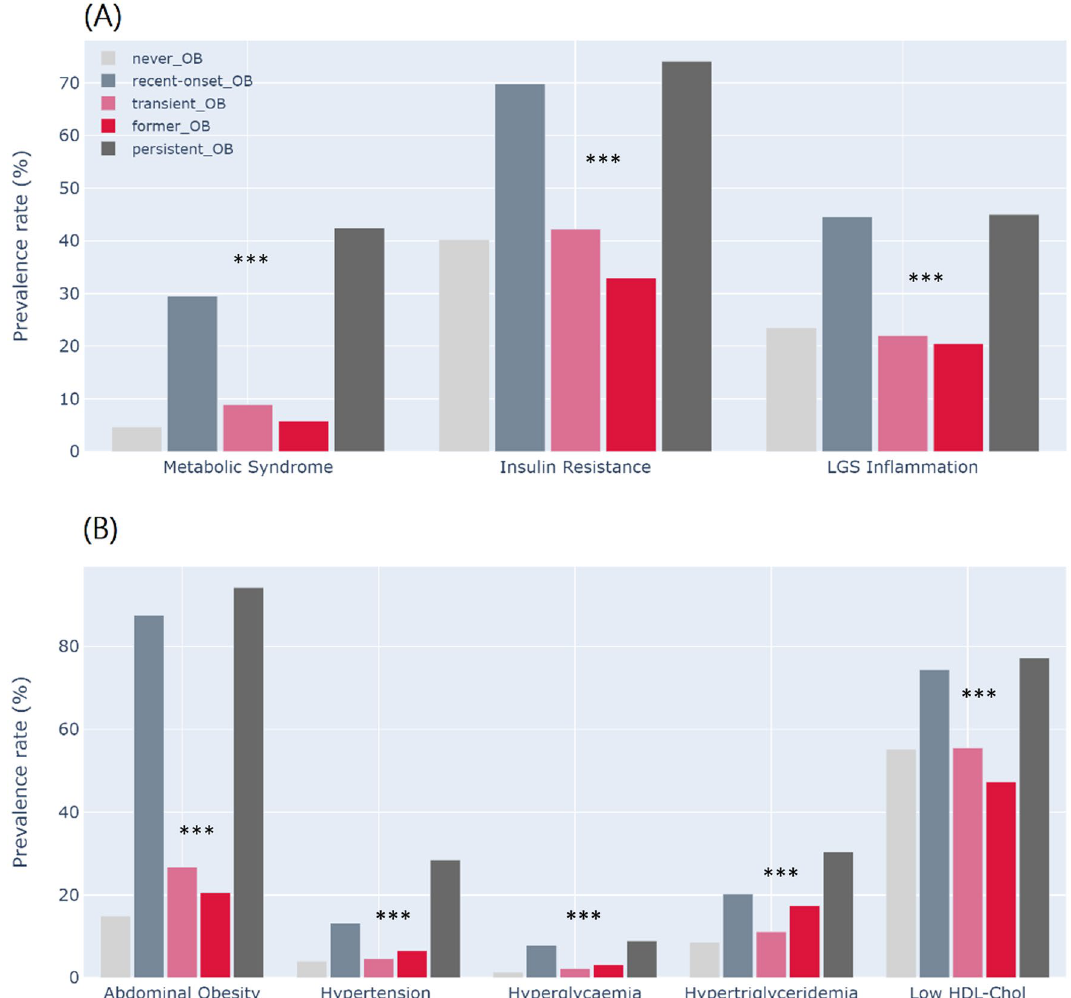
Figure 2. Cardiometabolic risk at 23 years by time of onset and persistence of obesity in the Santiago Longitudinal Study (n = 1039). Metabolic Syndrome (Mets) and its components were diagnosed with the AHA/ NHBLI/IDF joint standard. Insulin resistance diagnosed with HOMA-IR values ≥ 2.6. Low-Grade Systemic (LGS) Inflammation diagnosed with high sensitivity C-reactive protein values ≥ 3 mg/l (participants with values ≥ 9 mg/l were excluded from de analysis; n = 171). MetS components: abdominal obesity (WC ≥ 80 and 90 cm in females and males, respectively), high blood arterial pressure (SBP ≥ 130 mmHg, DBP ≥ 85 mmHg), hypertriglyceridemia (TG ≥ 150 mg/dL), low HDL (≤ 50 and ≤ 40 mg/dL in females and males, respectively), and fasting hyperglycaemia (Gli ≥ 100 mg/dl). Participants who were never obese (never-OBs); participants with obesity starting in adolescence and remained obese into adulthood (recent-onset-OBs); participants who were obese in early childhood but transitioned to non-obesity as preadolescents (former-OBs); participants who were obese in early childhood and remained obese into adulthood (persistent-OBs); and participants with obesity starting in preadolescence and transitioned to non-obesity as adolescents (transient-OBs). Prevalence rates of participants that solved obesity are shown in pink (transient-OBs) and red (former-OBs) shades. Pearson’s Chi 2 test for independence: * P < 0.05, ** P < 0.01, *** P < normal ranges. In all other biomarkers considered in the analysis, we found no differences between never-OBs with former-OBs and transient-OBs, suggesting a similar cardiometabolic profile in early adulthood. A post-hoc comparison after regression (Fig. 3), revealed the following: (1) recent-onset-OBs and persistent- OBs had similar SBP (115 vs 118 mmHg), DBP (73 vs 76 mmHg), insulin (19.4 vs 20.2 uUI/dl), HOMA-IR (4.35 vs 4.63), TG (11.4 vs 127.7 mg/dl), HDL-chol (41.4 vs 38.0 mg/dl), hs-CRP (3.14 vs. 3.23 mg/l), and adiponectin (5.65 µg/ml both groups); (2) recent-onset-OBs and persistent-OBs had increased values in all biomarkers con- sidered in the analysis compared to former-OBs and transient-OBs; (3) persistent-OBs also had higher MetS score compared to recent-onset-OBs (− 0.07 vs 0.17 SD ; P < 0.01).